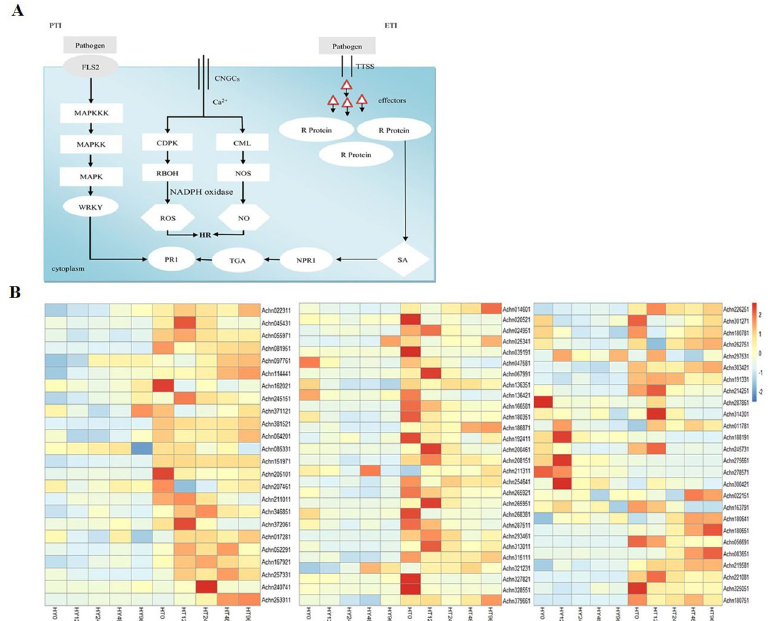
Fig 6. Expression patterns of the DEGs involved in PTI and ETI at different time points (0, 12, 24, 48, and 96 hai) in response to Psa infection in Huate (HT) and Hongyang (HY). (A) Schematic diagram of the plant’s innate immune system response to Psa inoculation. (B) Heat maps of DEGs involved in PTI and ETI at different time points (0, 12, 24, 48 and 96 hai) in response to Psa infection in HY and HT. Gene expression level was measured using the FPKM method (expected number of fragments per kilobase of transcript sequence per millions of base pairs sequenced). Horizontal axes represent gene ID, and vertical axes represent 0, 12, 24, 48, and 96 hai (from left to right) with Psa in HY and HT. Heat map shows the expression of genes ranging from blue (low expression) to red (high expression).